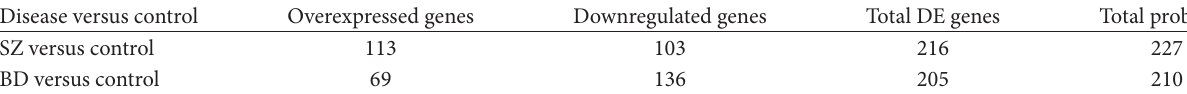
Study 1 DE genes from BD patients